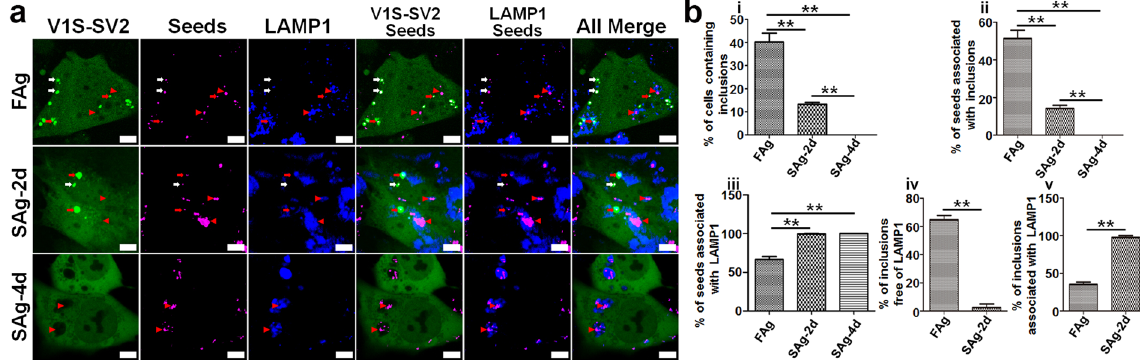
Figure 4. Seeding activity is related to pathway of α S seeds. (a) H4/V1S-SV2/LAMP1-eCFP cells were treated with DyLight ® 650 labeled FAg, SAg-2d, or FAg-4d for 2 days followed by imaging under confocal microscopy. White and red arrows respectively denote α S seeds and induced endo-lysosome-free (white), endo-lysosome- associated (red) α S inclusions; red arrowheads denote endo-lysosome-associated α S seeds without induction of an α S inclusion. Scale bar: 5 µ m. (b) i, ii &iii: quantitation of FAg, SAg-2d, and SAg-4d treated cells expressed as the ratio of cells with inclusions to total cells, inclusions to total seeds, and LAMP1-positive seeds to total seeds; iv &v: quantitation of FAg and SAg-2d treated cells expressed as the ratio of LAMP1-negative and LAMP1- positive inclusions to total inclusions. Error bars represent standard error of the mean ( * p < 0.05, ** p < 0.01, comparing subsets linked by line, n =